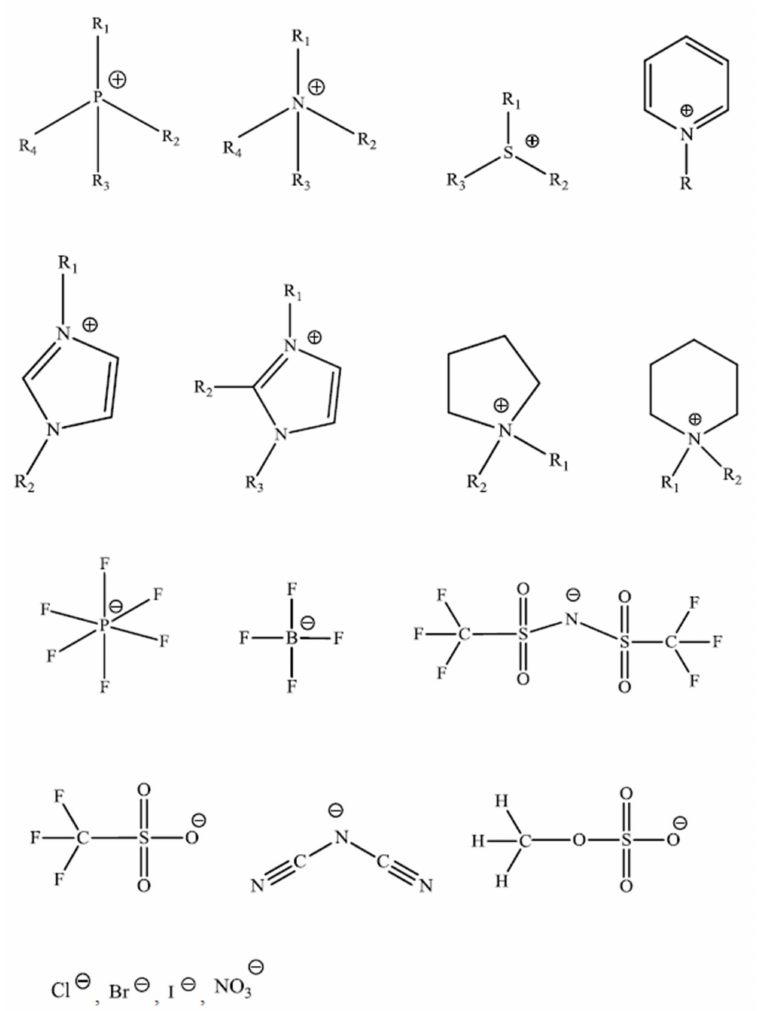
Figure 2. Some typical cations and anions used for the synthesis of ILs. Figure is reproduced from